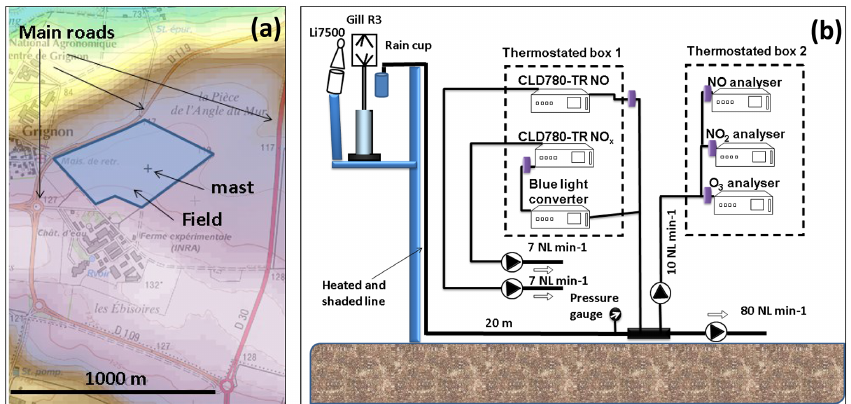
Figure 1. (a) Simplified map of the FR-GRI field site showing the mast and surrounding roads. The colours correspond to elevation. (b) Sim- plified sketch of the instrumental setup to measure EC fluxes. Gill R3 is the ultrasonic anemometer, Li7500 is the open-path infrared CO 2 and H 2 O gas analyser, the rain cup is the air sampler for NO and NO 2 detection. CLD780-TR NO and NO x are the fast-response NO anal- ysers (Ecophysics) operating in parallel, one connected to a BLC measuring NO + α NO 2 . The NO, NO 2 and O 3 slow analysers (Thermo Scientific, Waltham, USA) are placed behind a Teflon pump ensuring atmospheric pressure at the inlet. A large pallet pump ensured a flow rate of 80NLmin − 1 in the heated inlet line. Teflon filters (1µm) were installed at the front of the instrument inlets (purple